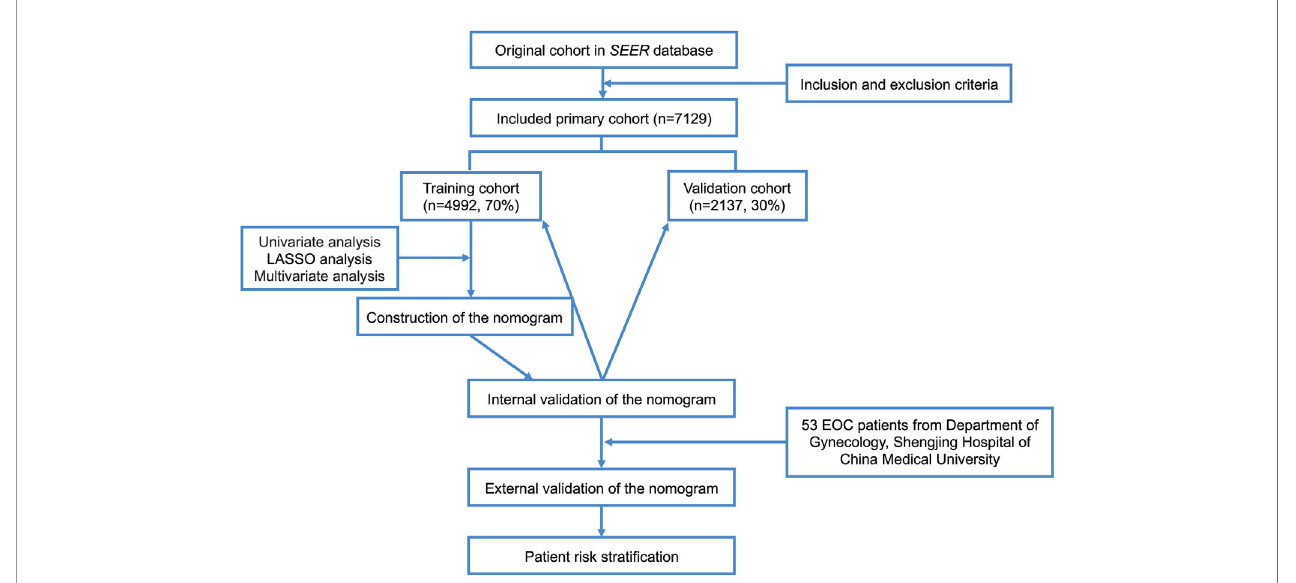
FIGURE 1 | Flow chart of study